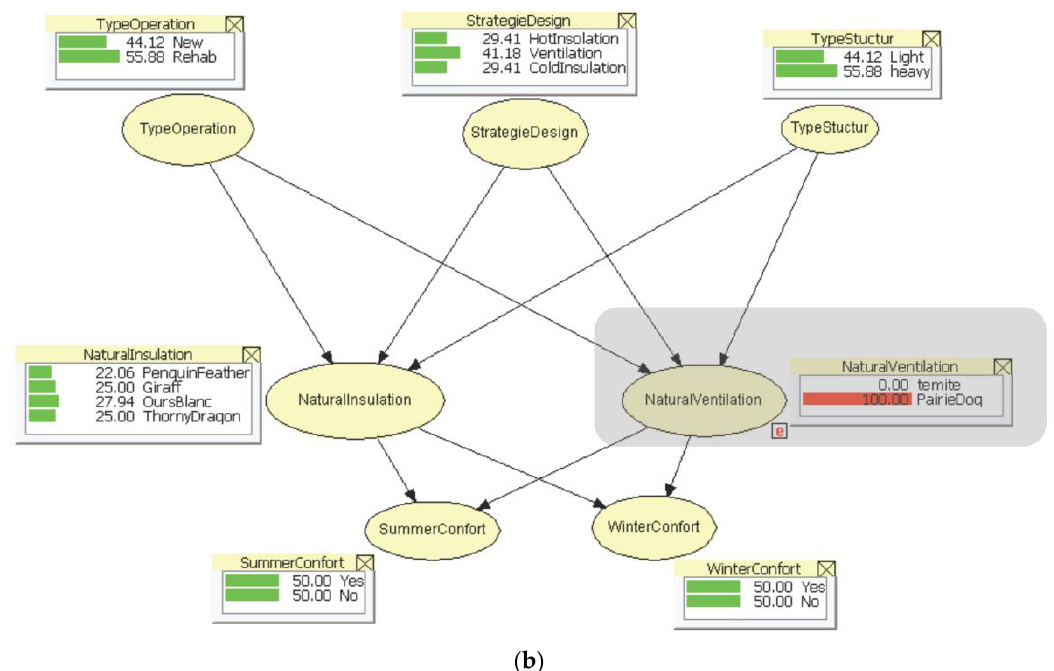
Figure 10. Information given tool: exploring nature strategy to suitable multi-criteria requirements ( a ) Potential use of Giraffe skin as natural insulation strategy; ( b ) Potential use of Prairie dog as natural ventilation.